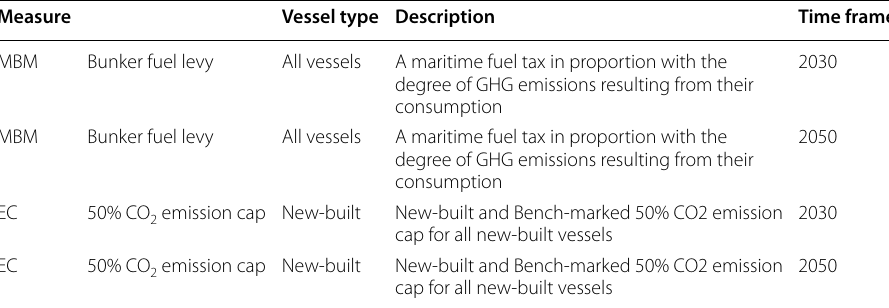
Table 2 Selected regulatory scenarios to be considered in this research